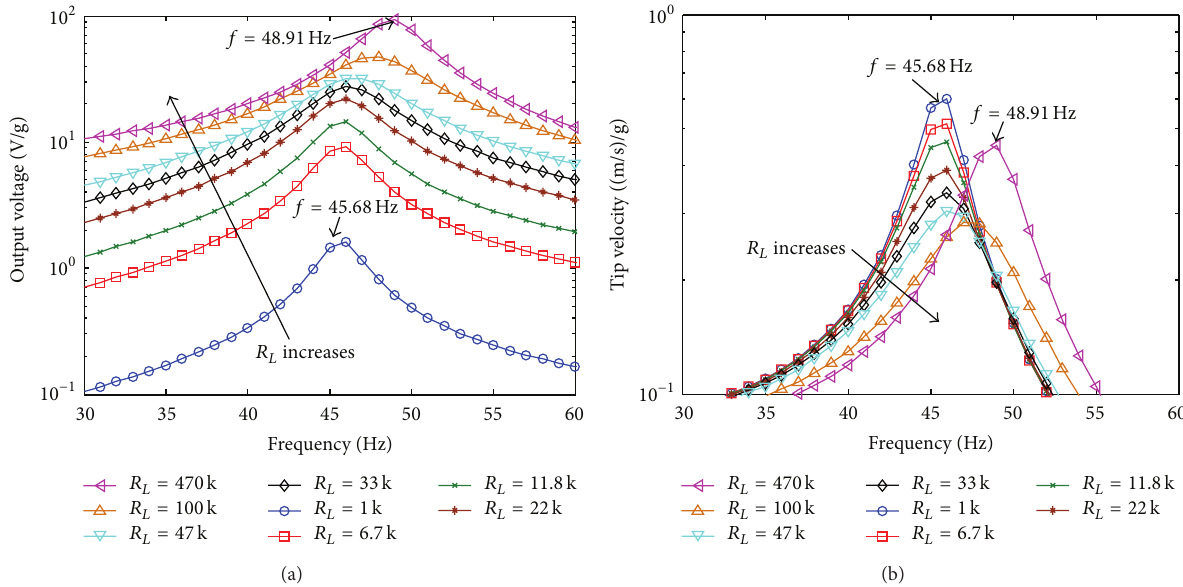
Figure 8: Output voltage (a) and tip velocity (b) of the PVEH for various values of load resistance.